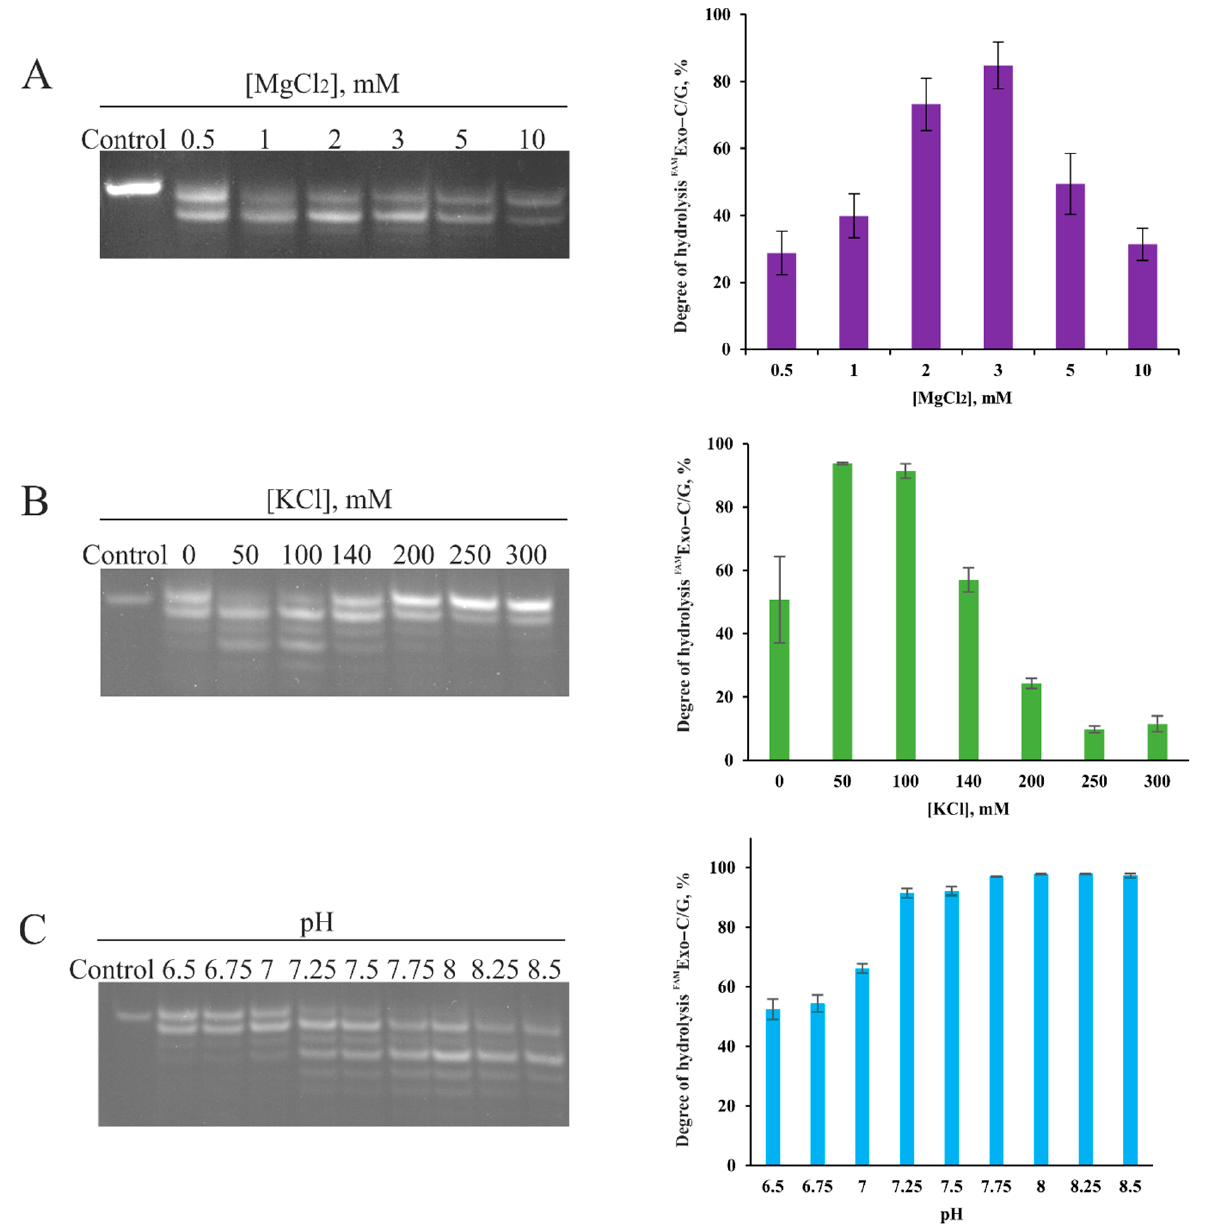
Figure 1. Digestion of substrate FAM Exo–C/G at various concentrations of MgCl 2 (t = 1 h) ( A ) and of KCl (t = 30 min) ( B ) and at various pH levels (t = 30 min) ( C ). ([Apn2] = 2 μ M, [DNA] = 1 μ M, T = 37°C).